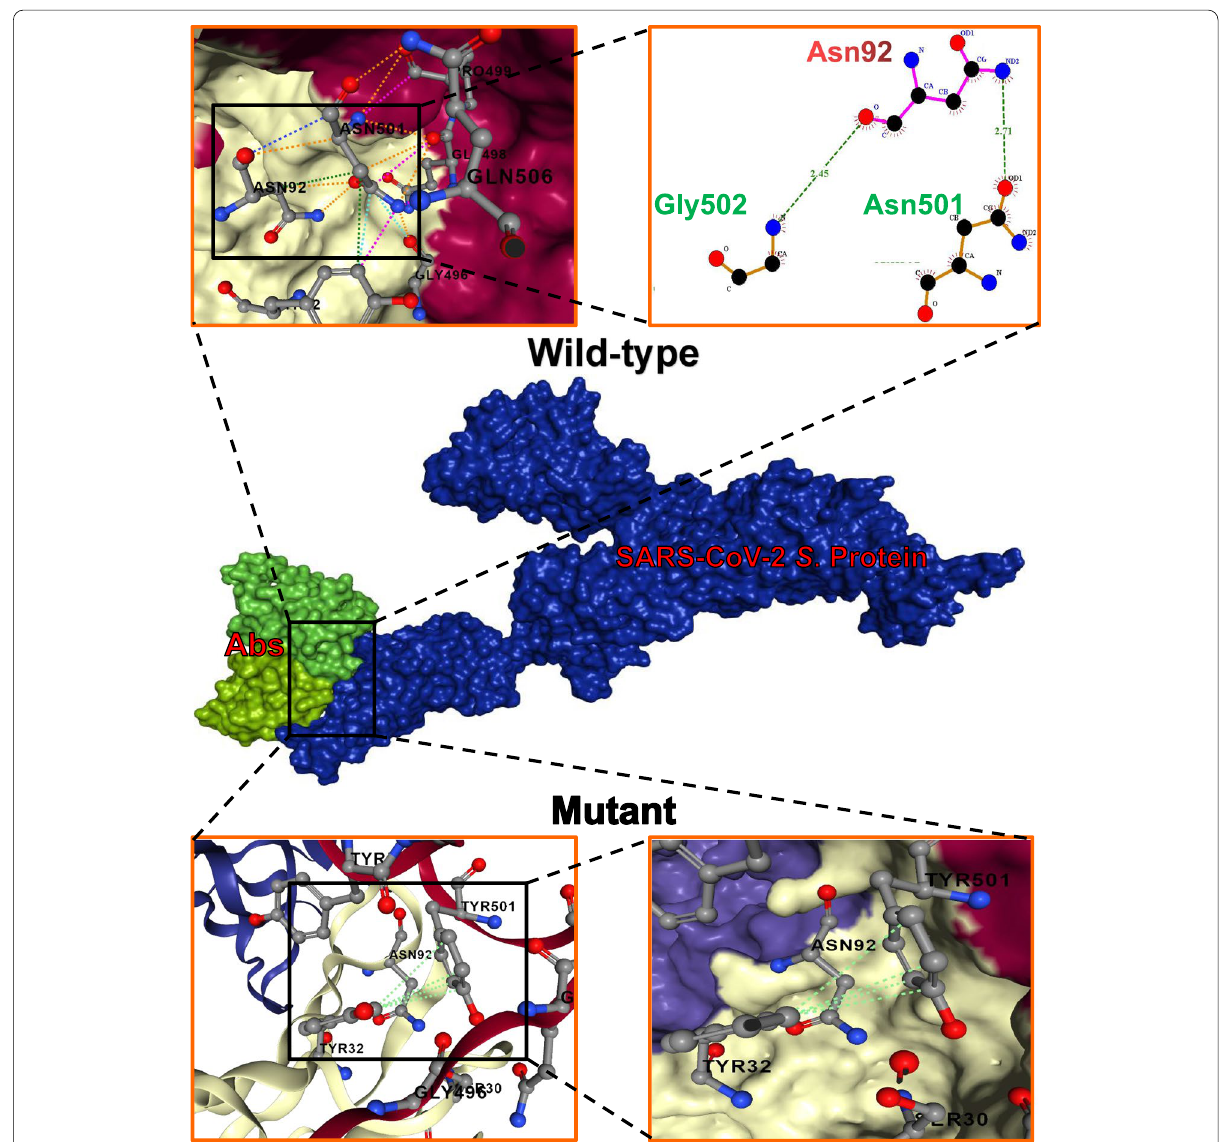
Fig. 2 Interface analysis of the wild-type and mutant SARS-CoV-2 spike glycoprotein upon the docking of antibody against the RBD. The mid-segment shows a surface representation of the protein-antibody interaction, with the 3D structure of the full-length SARS-CoV-2 spike glycoprotein coloured in blue, and both chains of the antibody colored in different shades of green. The top and bottom segments show details of the observed changes in the interaction between the wild-type and mutant spike glycoprotein upon the N501Y